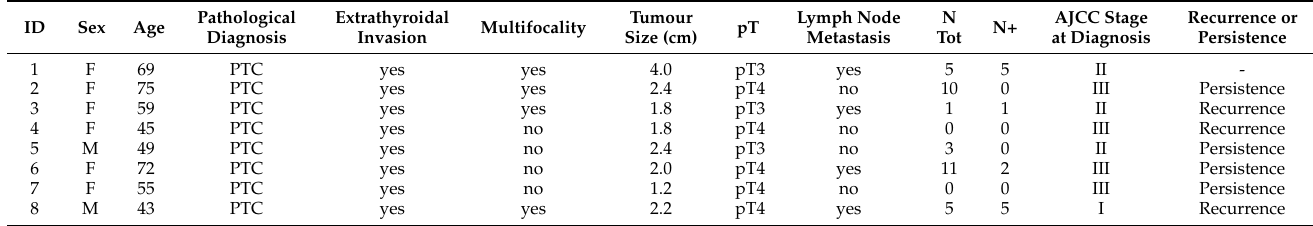
Table 2. Clinical characteristics of patients with PTC invading the airway.